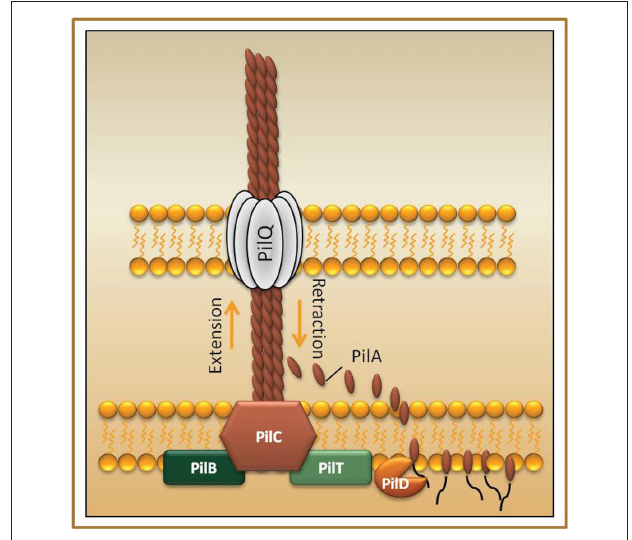
FIGure 1 | Schematic overview of the type IV pili system. The pilus fiber is mainly composed of the major pilin subunit (denoted PilA in P. aeruginosa ), which is expressed as a prepilin that upon cleavage by the prepilin peptidase PilD allows for proper pilus assembly and function (Strom et al., 1993). The major pilin is translocated across the inner membrane where it forms a dynamic multimeric filament that is secreted via the pore-forming secretin PilQ to the bacterial surface (Marceau et al., 1998). PilC is a transmembrane protein found in the inner membrane (Nunn et al., 1990). The two ATPases, PilB and PilT, mediates extension and retraction respectively of the pilus (Whitchurch et al., 1991; Maier et al., 2004).